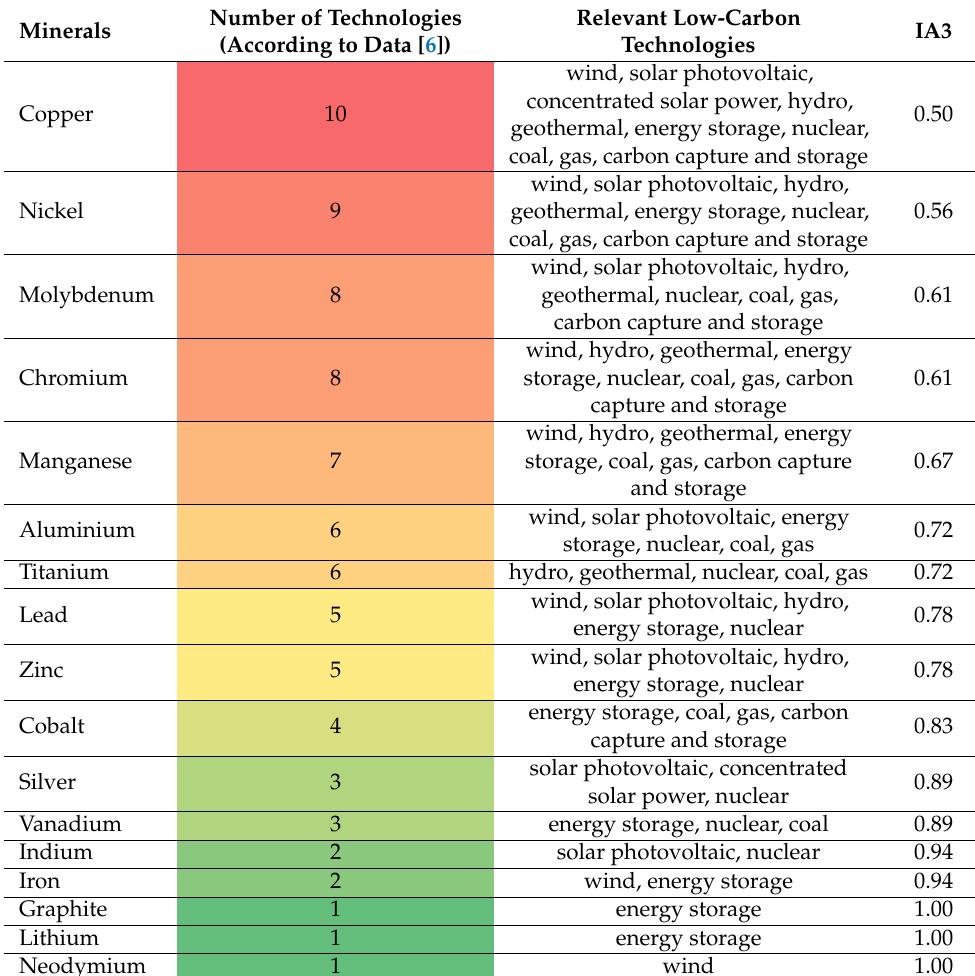
Table A3. Ranking of minerals by demand indicators from relevant low-carbon technologies.